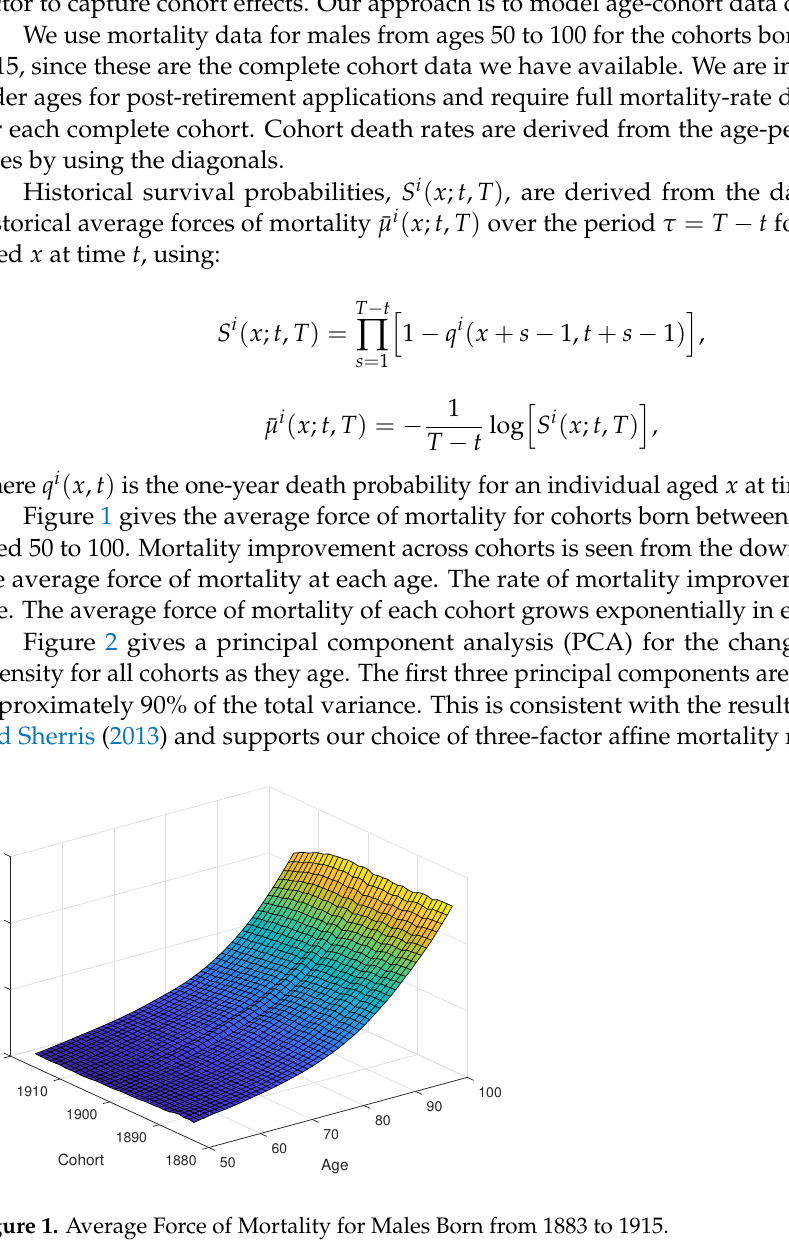
Figure 1. Average Force of Mortality for Males Born from 1883 to